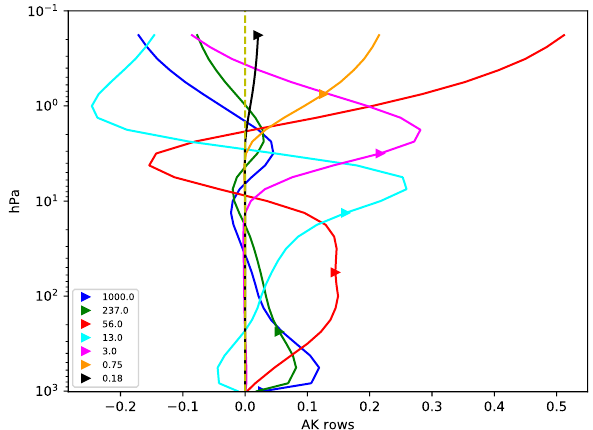
Figure 2. Example of the averaging kernel shape for a subset of seven layers from a 31-layer SCIAMACHY ozone profile retrieval. The triangles are the pressure levels in hPa of the retrieval layers. This subset of seven retrieval layers was selected uniformly ranging from top to bottom for